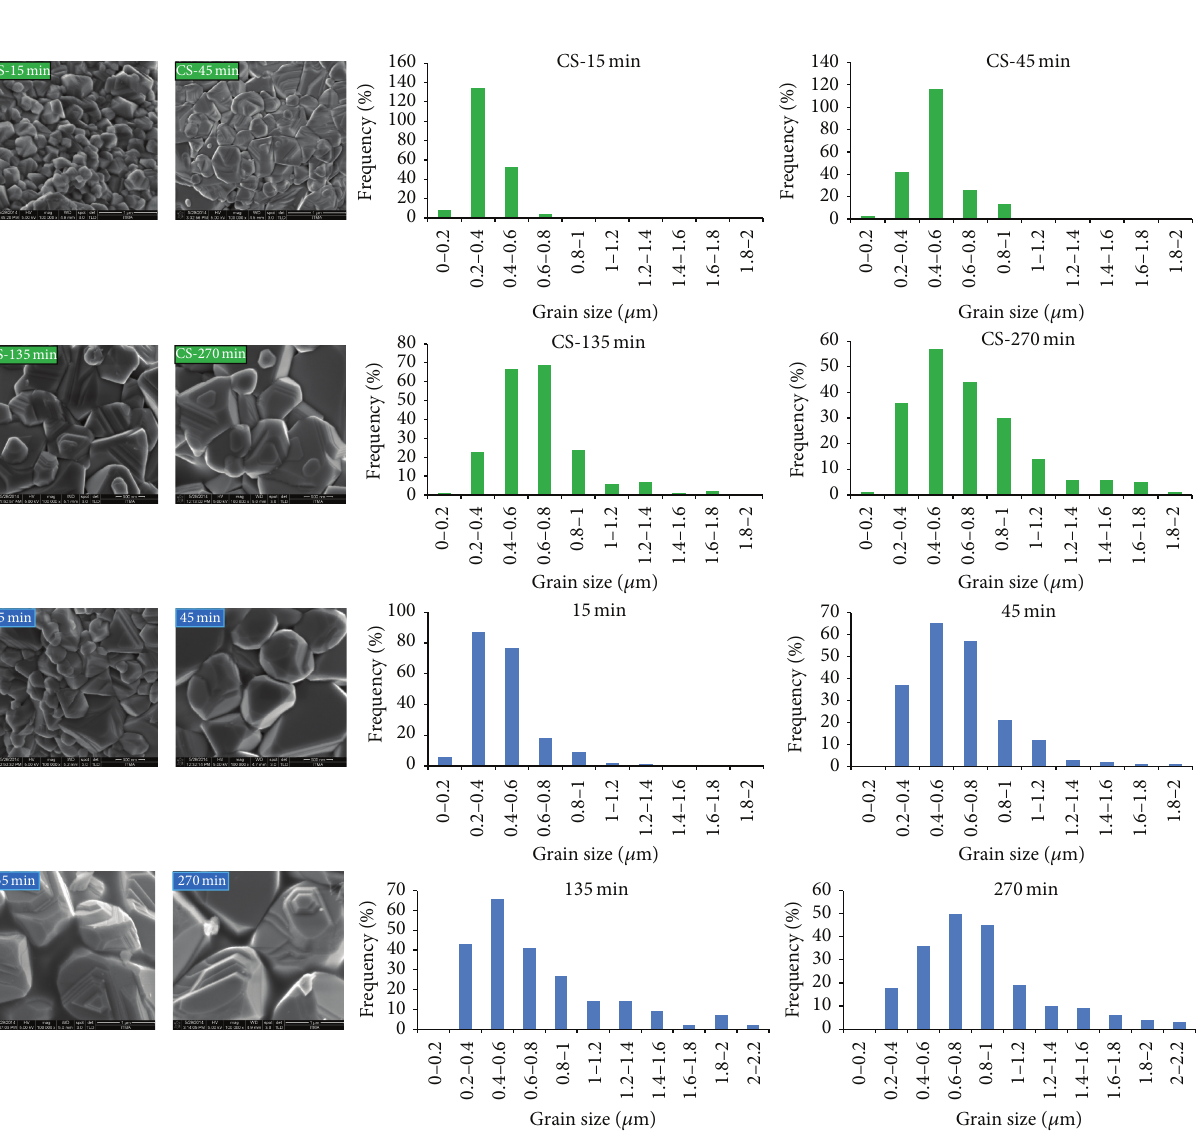
Figure 2: FeSEM images of the two types of samples sintered at different times with their corresponding grain size distribution histograms.